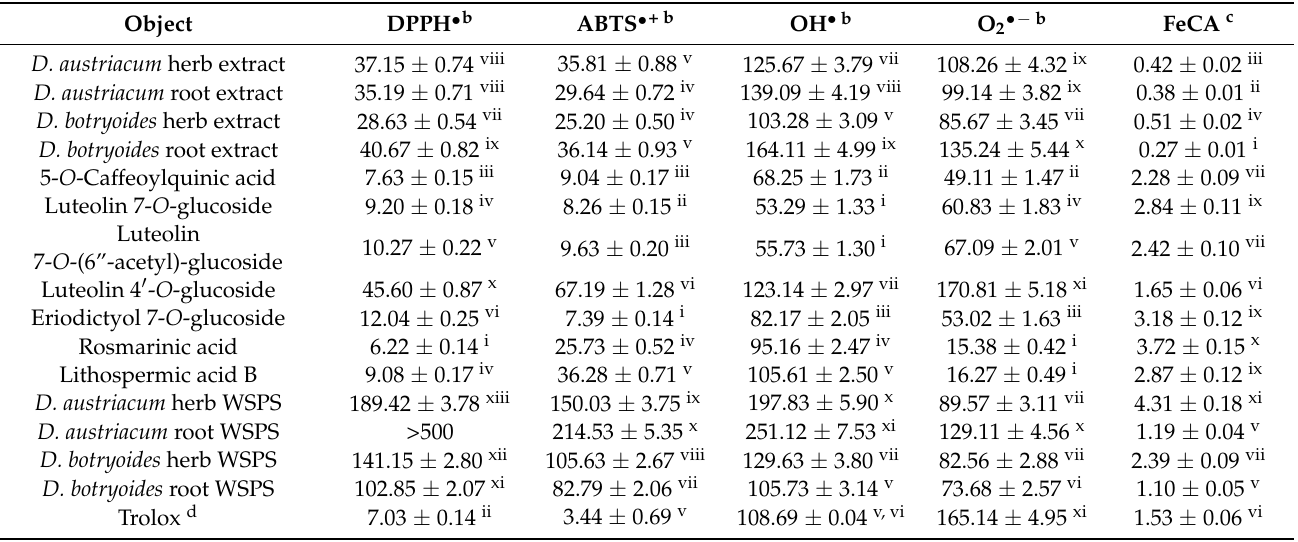
Table 4. Bioactivity of extracts of D. austriacum and D. botryoides , selected phenolics and water-soluble polysaccharides (WSPS) in five antioxidant assays a